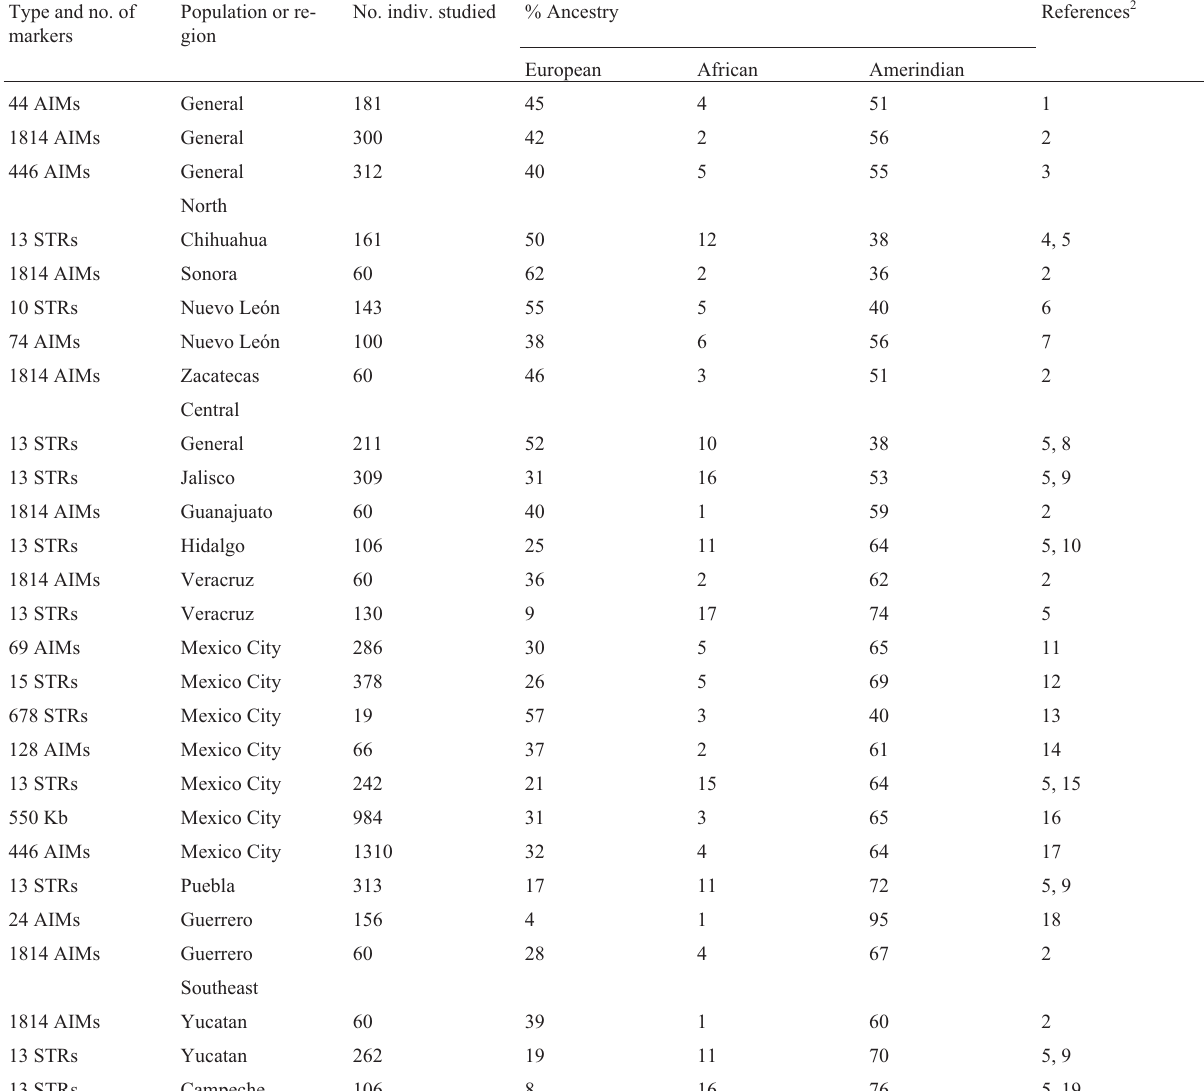
Table 1 - Molecular autosome estimates of parental continental ancestry in different segments of the Mexican population 1 . Type and no. of